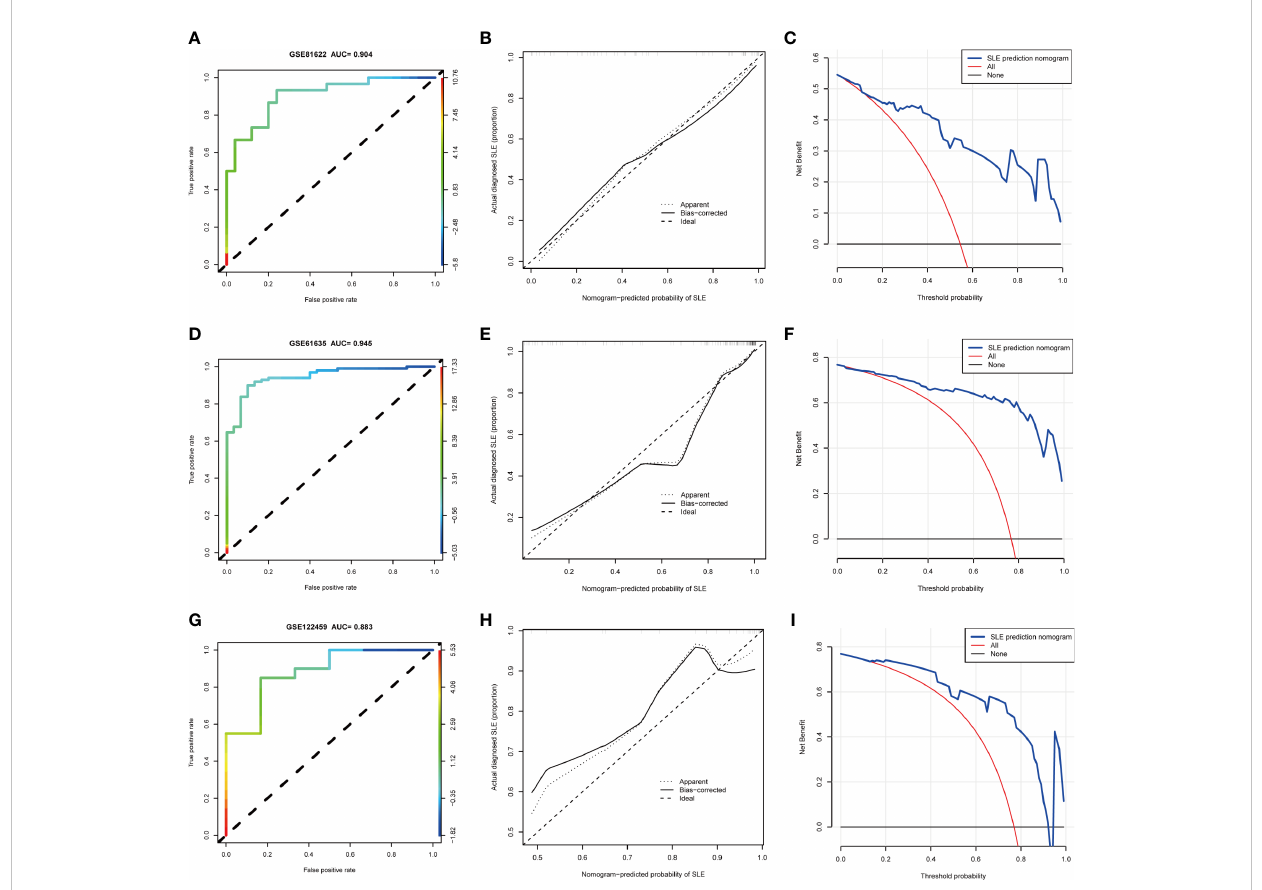
FIGURE 7 The performance of hub genes in the validation sets. (A – C) . GSE81622. (D – F) . GSE61635. (G – I) .